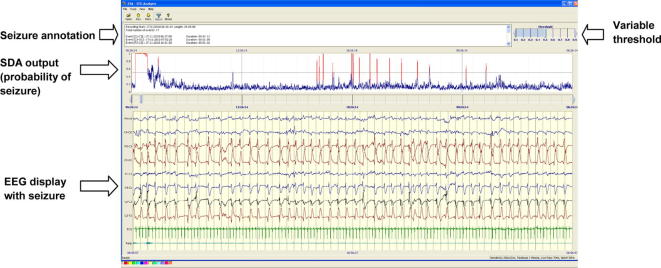
Automated seizure detection algorithm. Lower panel shows EEG reader displaying a seizure. Upper panel shows output of SDA. Blue trace is a graph of the probability of seizure. When the trace breeches an adjustable sensitivity threshold a seizure is designated, the trace turns red and an annotation of seizure time and duration is created.